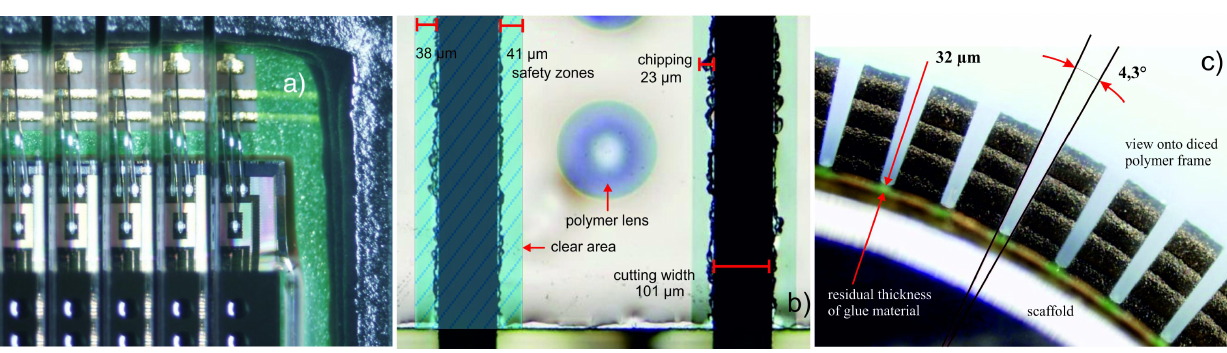
Figure 11. ( a ) Black polymer frame used as a wall for the wire potting. ( b ) Top view of one column after dicing with its safety zones preventing deterioration due to chipping. ( c ) Side view onto the glob-top frame after bending of the flexible sensor array with respect to a pre-defined curvature of a